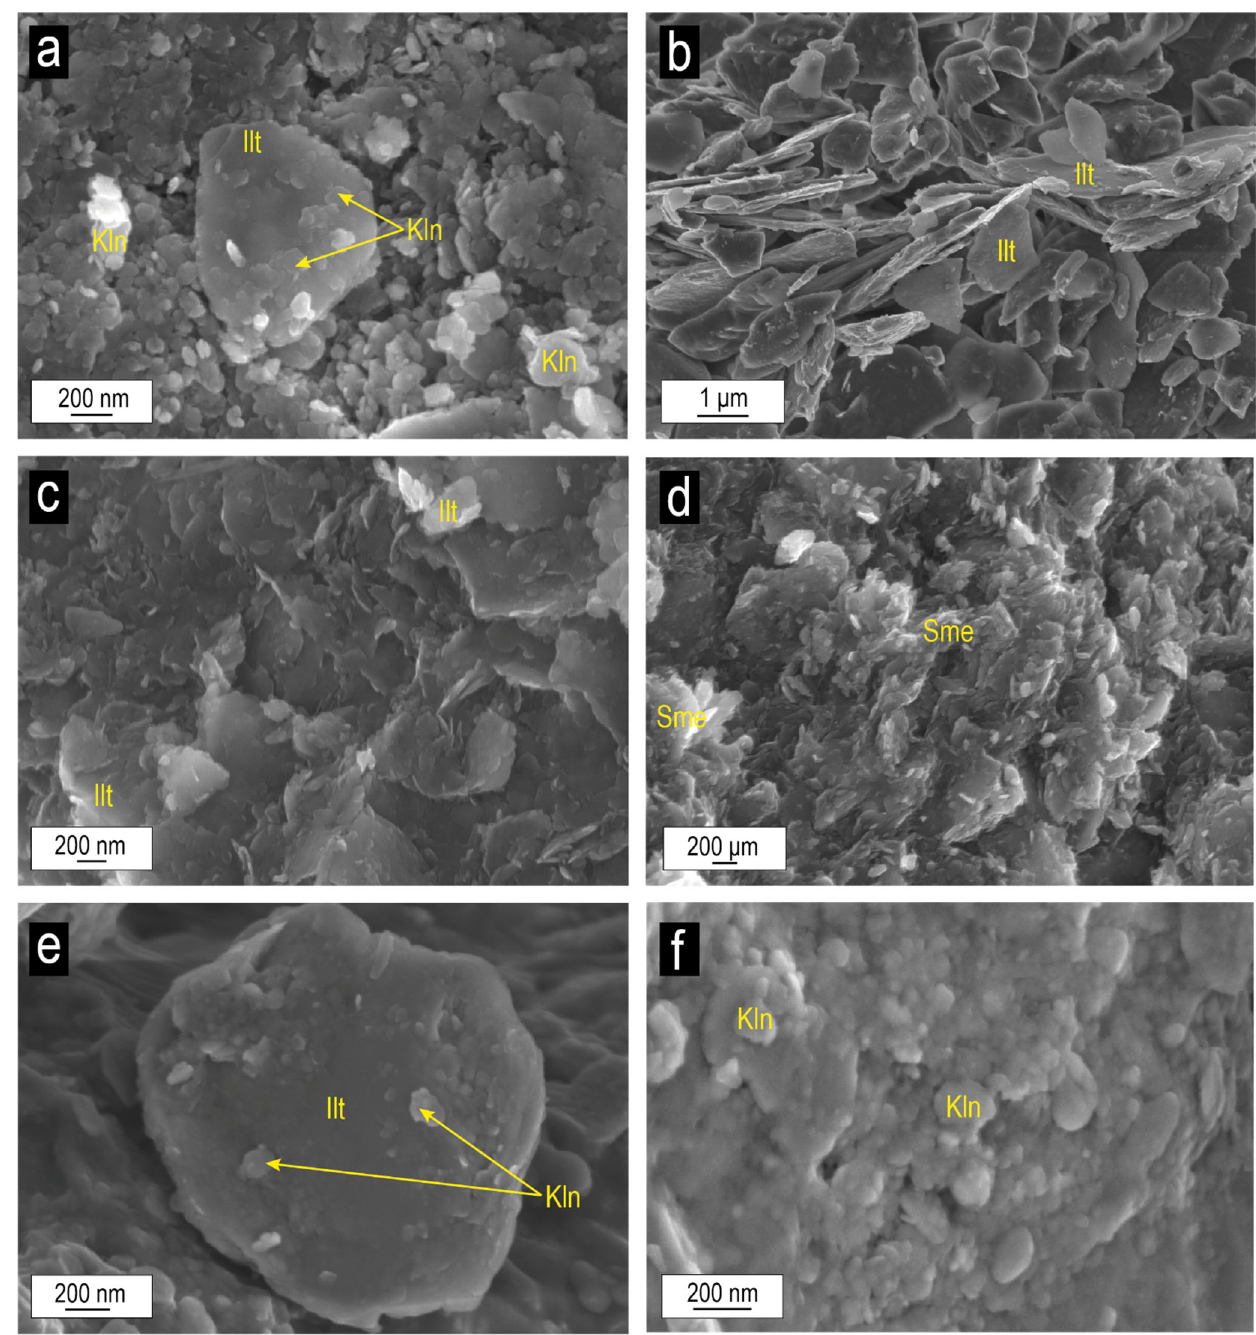
Figure 6. Secondary electron images showing: ( a ) illitic phases plates with anhedral morphologies and subhedral kaolinite plates in terrestrial samples; ( b ) illitic phases plates with anhedral morphologies in terrestrial samples; ( c ) illitic phases with wavy morphologies in submerged samples and EDS patterns of the illitic phases; ( d ) smectite with flake morphologies in submerged samples and EDS patterns of smectite; ( e ) illitic phases plates with anhedral morphologies and anhedral kaolinite plates in the soil sample; ( f ) anhedral kaolinite plates in the soil sample. Kln = Kaolinite; Ilt = Illitic phases; Sme = Smectite.